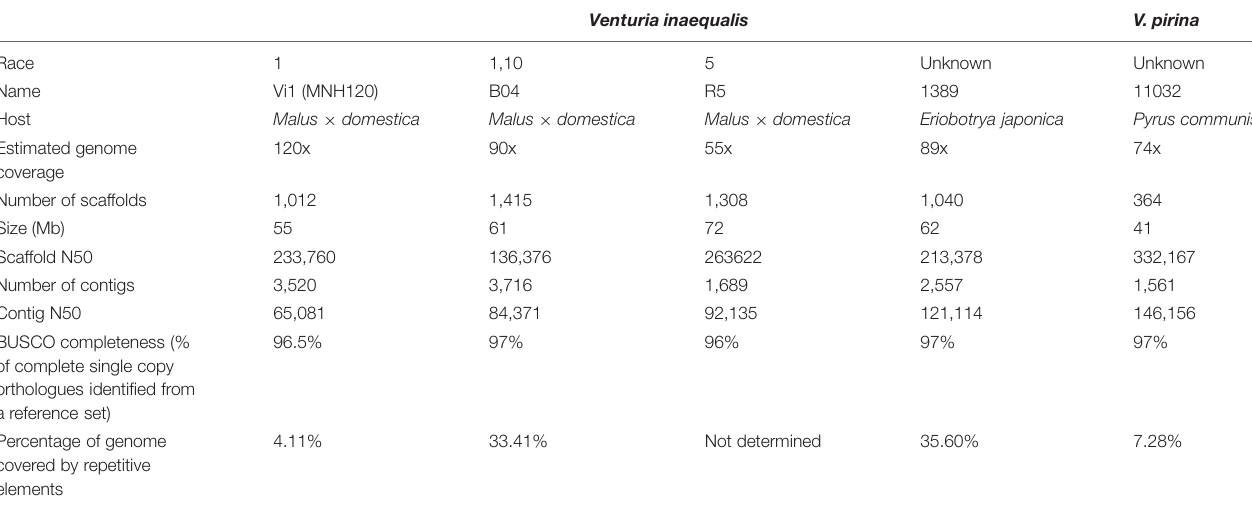
TABLE 1 | Genome sequence summary statistics for each Venturia isolate included in this